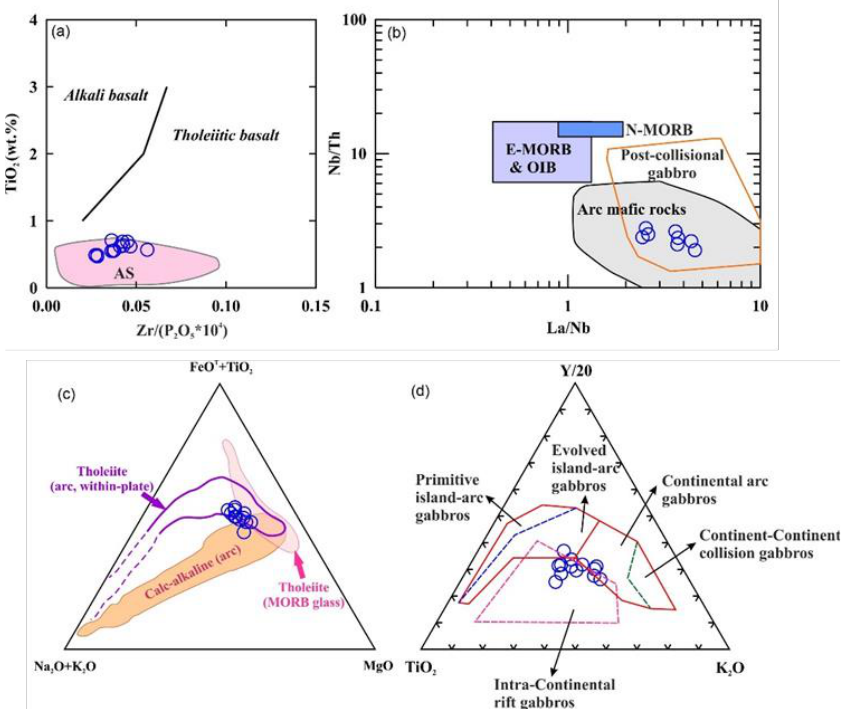
Figure 8. ( a ) Zr/(P 2 O 5 × 104) vs. TiO 2 diagram [79]. AS field represents post-collisional gabbros from Arabian Shield [8]; ( b ) La/Nb vs. Nb/Th diagram [80]. Post-collisional gabbros field is from Khalil et al. [10] and Ali and Alshammari [8]; ( c ) discrimination diagram for calc-alkaline and tholeiite igneous rocks [44]; and ( d ) TiO 2 – Y/20 – K 2 O triangular diagram discriminating between arc and continental gabbros [81].